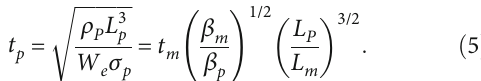
Figure 12: Flow velocity of di ff erent volume